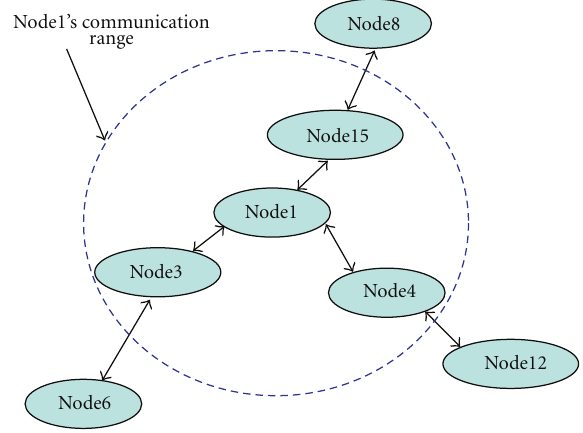
Figure 8: An example of synchronous process.